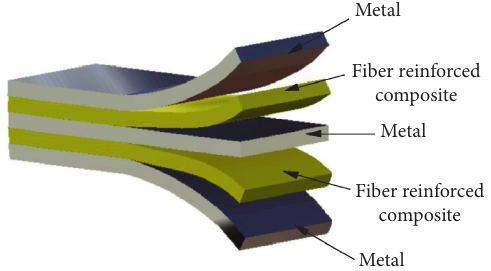
Figure 1: Composition of